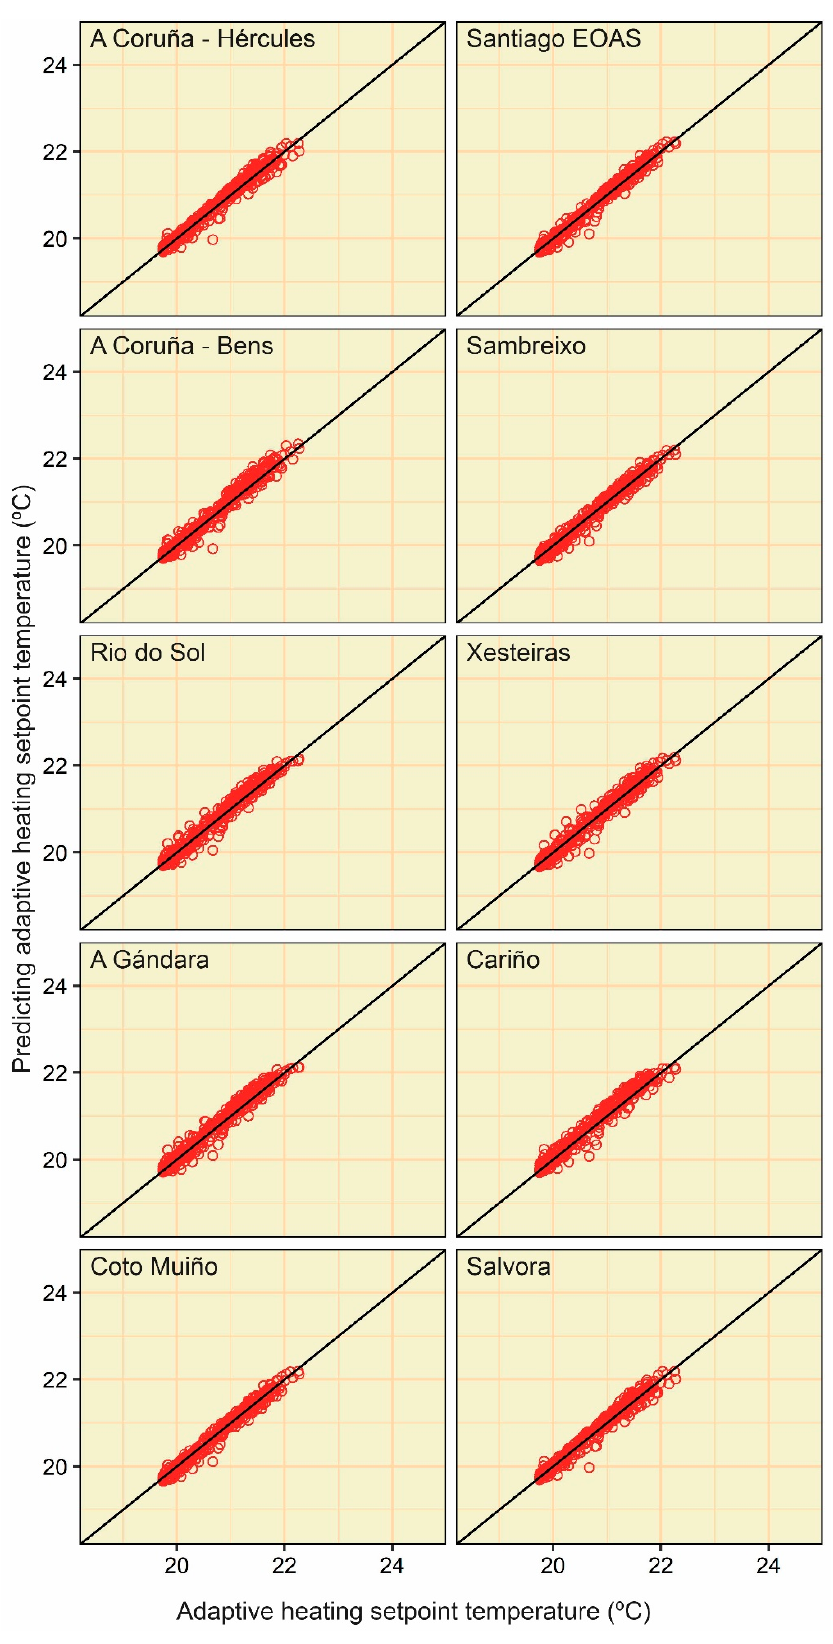
Figure A18. Point clouds between the actual and predicting adaptive heating setpoint temperature values (category III) of the MLP (approach 1).